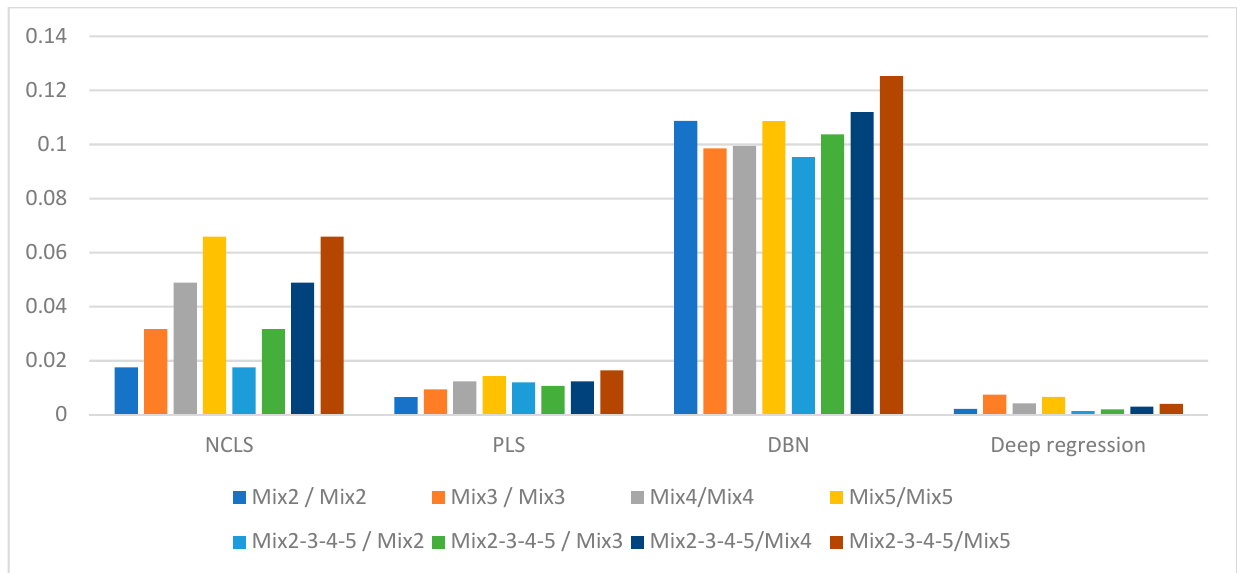
Figure 7. Average RMSE comparison using bar plots for “high-mixing-rate mixture” dataset with respect to case (Mixing-rate range used for synthesizing mixtures is: [0.25 3.00], Min: 0.25 Max: 3.00).